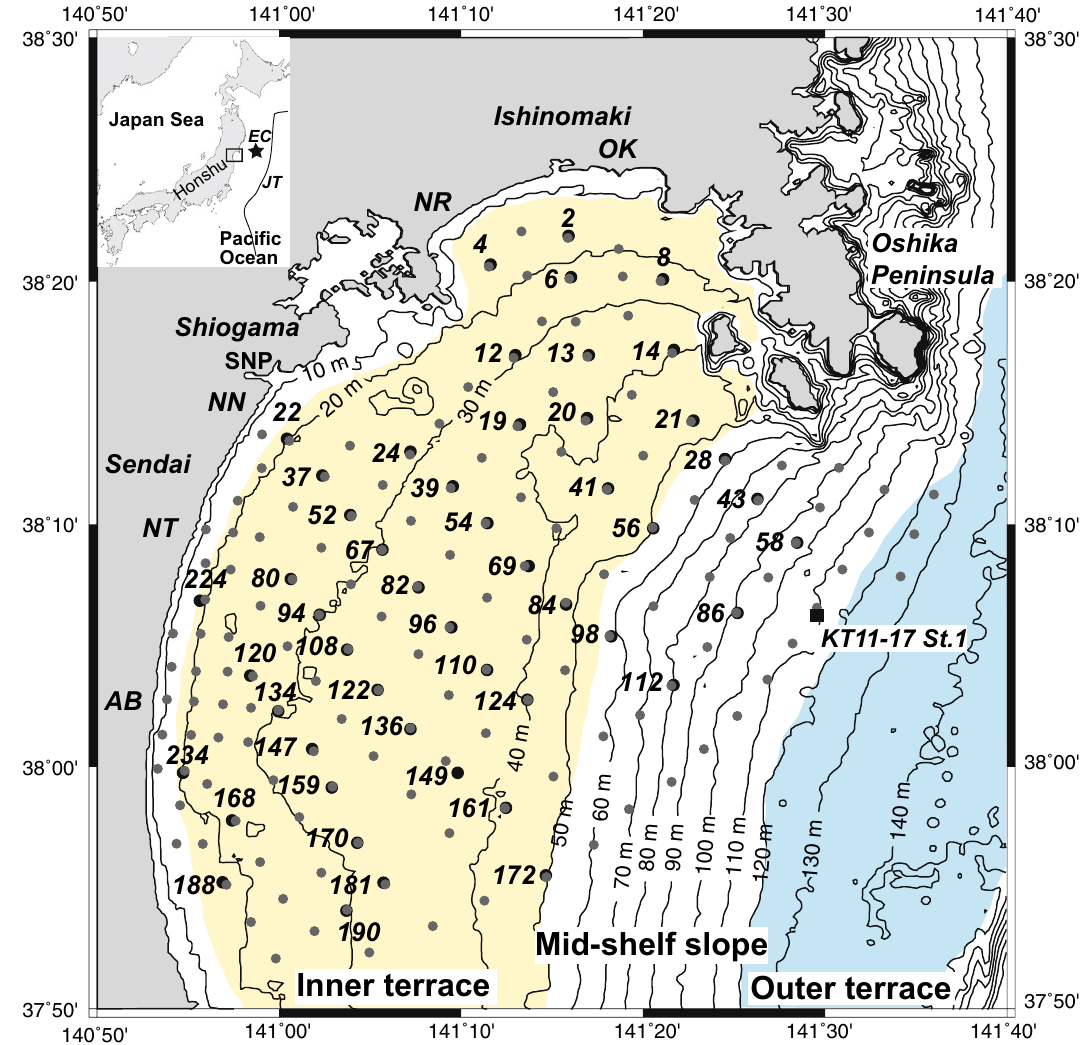
Figure 1. Location and bathymetry of Sendai Bay and surface sediment sampling locations. Black solid circle; the 2012 sediment sampling location, gray solid circle; the 1985 sediment sampling location. Yellow; inner terrace, blue; outer terrace. AB; Abukuma River mouth, NT; Natori River mouth, NN; Nanakita River mouth, NR; Naruse River mouth; OK; Old Kitakami River mouth; SNP; Sendai New Port, JT; Japan Trench; EC; Epicenter of the 2011 Tohoku-oki